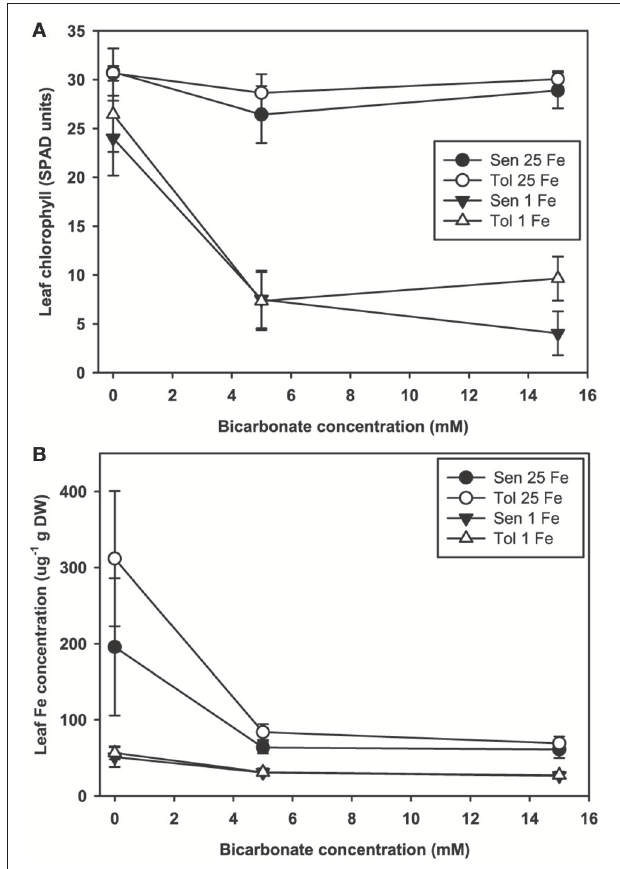
FIGURE 2 | Leaf chlorophyll and iron (Fe) concentration in IDC tolerant and sensitive soybean plants. (A) chlorophyll (in SPAD units) and (B) Fe concentration in the first trifoliate leaf. Plants were pretreated with 1 or 25 µ M Fe(III)-EDDHA for 6 d then treated with 1 or 25 µ M Fe(III)-EDDHA and 0, 5, or 15mM sodium bicarbonate for 4 d. At low Fe supply, Bic treatment resulted in statistically significantly lower leaf chlorophyll ( p < 0.05), and the genotypes were significantly different at 15mM Bic. At both Fe levels, addition of Bic resulted in statistically significantly lower leaf Fe concentration ( p < 0.05), but there were no differences between